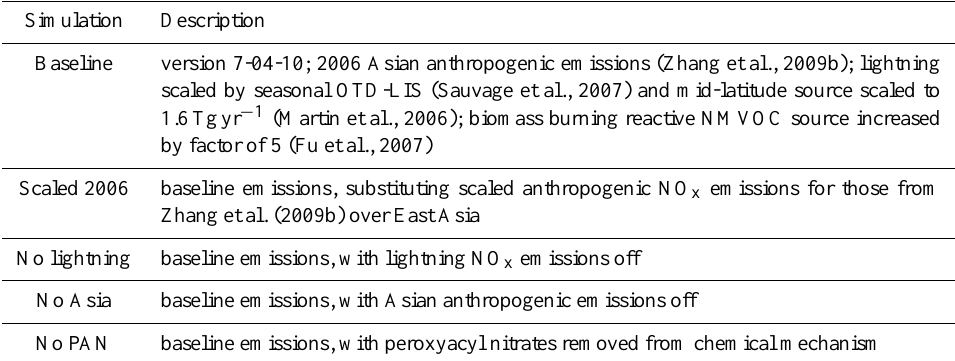
Table 1. Description of baseline and sensitivity simulations performed with the GEOS-Chem